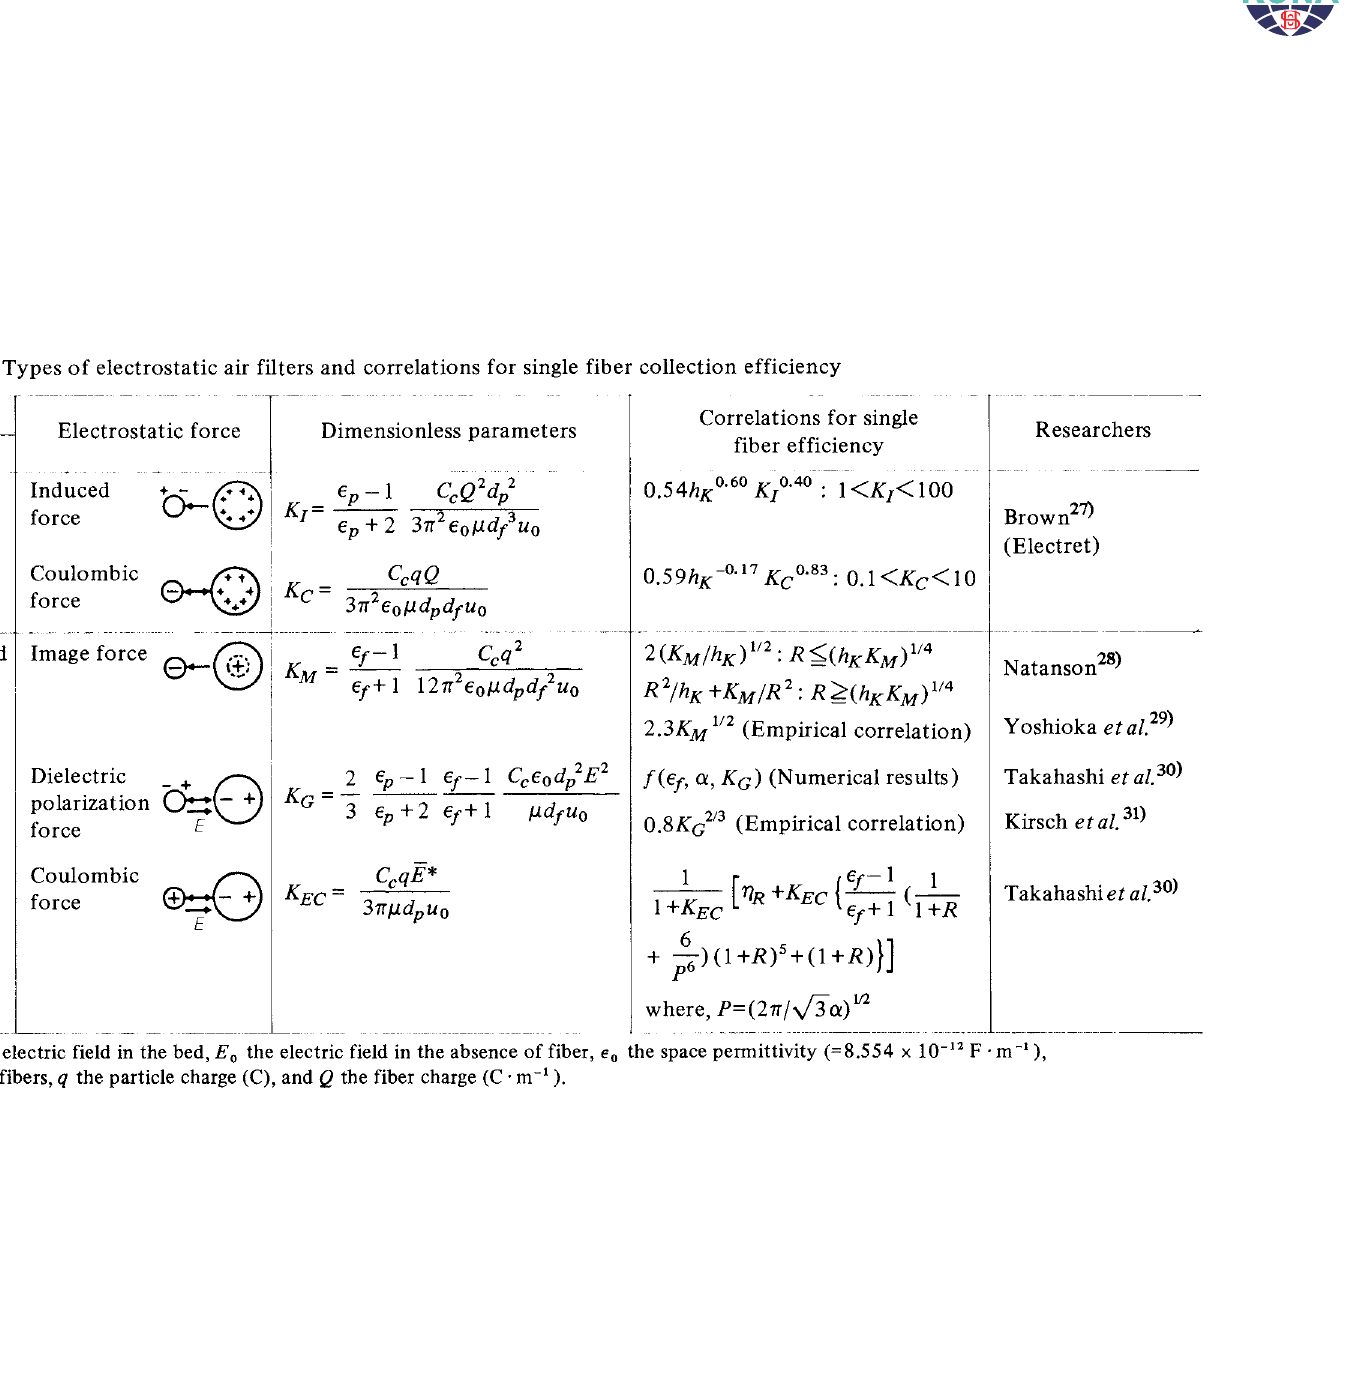
Table 5 Types of electrostatic air filters and correlations for single fiber collection